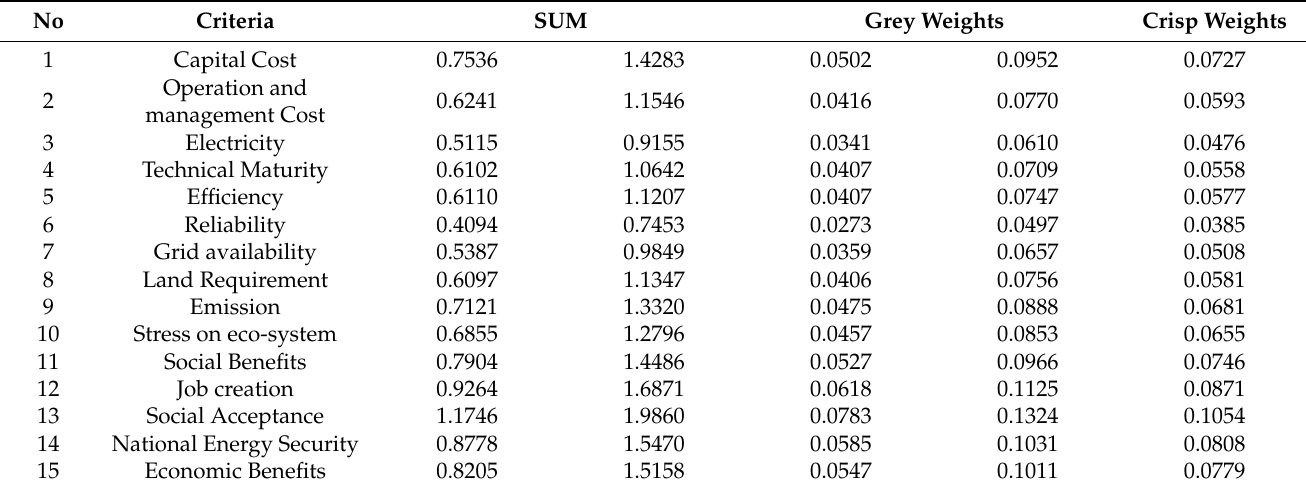
Table 5. Normalized Matrix.